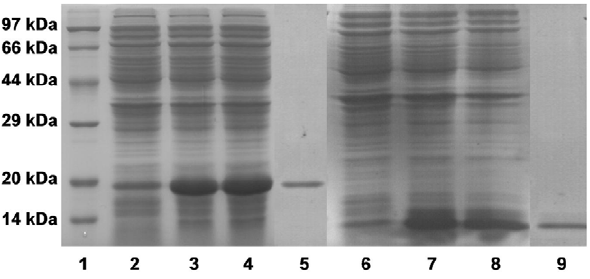
Figure 3. SDS-PAGE results of recombinant expression and purification of rEs-FABP9 and rEs-FABP10 in E. coli . Lane 1, protein standard; Lane 2, total proteins of E. coli transfected with pET28a-Es-FABP9, without induction; Lane 3, pellets of E. coli transfected with pET28a-Es-FABP9, induced with IPTG; Lane 4, supernatants of E. coli transfected with pET28a-Es-ABP9, induced with IPTG; Lane 5, recombinant rEs-FABP9 purified by His-Bind resin chromatography; Lane 6, total proteins of E. coli transfected with pET28a-Es-FABP10, without induction; Lane 7, pellets of E. coli transfected with pET28a-Es-FABP10, induced with IPTG; Lane 8, supernatants of E. coli transfected with pET28a-Es-ABP10, induced with IPTG; Lane 9, recombinant rEs-FABP10 purified by His-Bind resin chromatography.